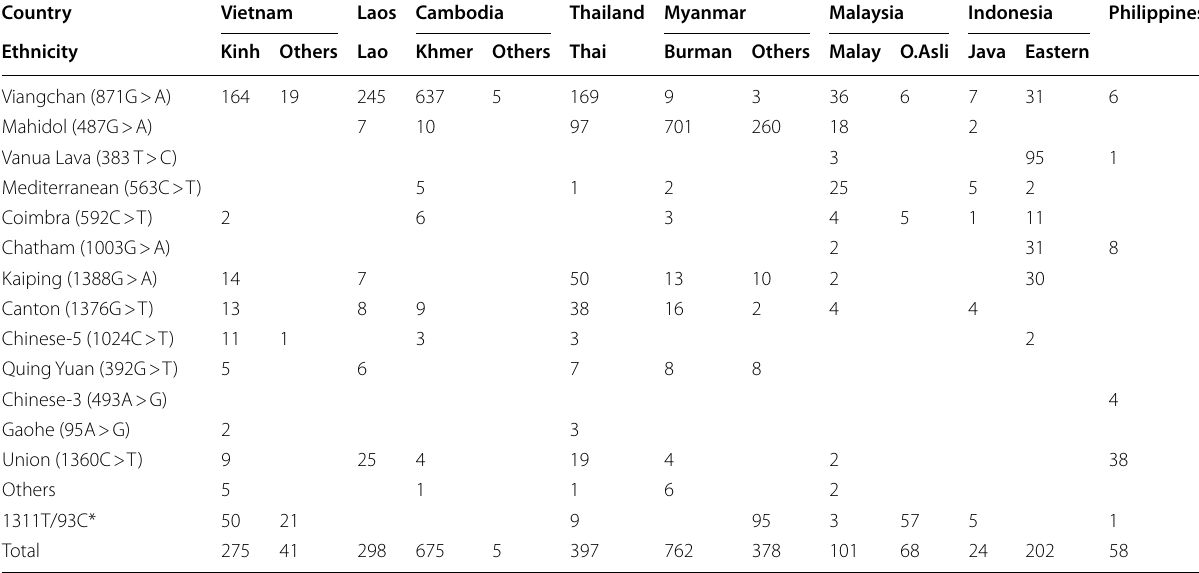
Data of Vietnam are reported from [6, 12, 16, 17], and Others include K’Ho and Stieng minorities. Data of Laos are reported from [7, 17–20] and from Laotian immigrants in Hawaii [21]. Data of Cambodia are reported from [10, 17, 19, 22–24], and Others include 3 minorities. Data of Thailand are reported from [17, 25–31]. Data of Myanmar are reported from [5, 7, 9, 17, 19, 28, 32–36] and Others included 6 minorities. Data of Malaysia are reported from [7, 37–40]. Data of western Indonesia are reported in Javanese, Betawi and Sundanese [7, 41, 42]. Data of eastern Indonesia are reported from [7, 8, 11, 13, 43]. Data of the Philippines